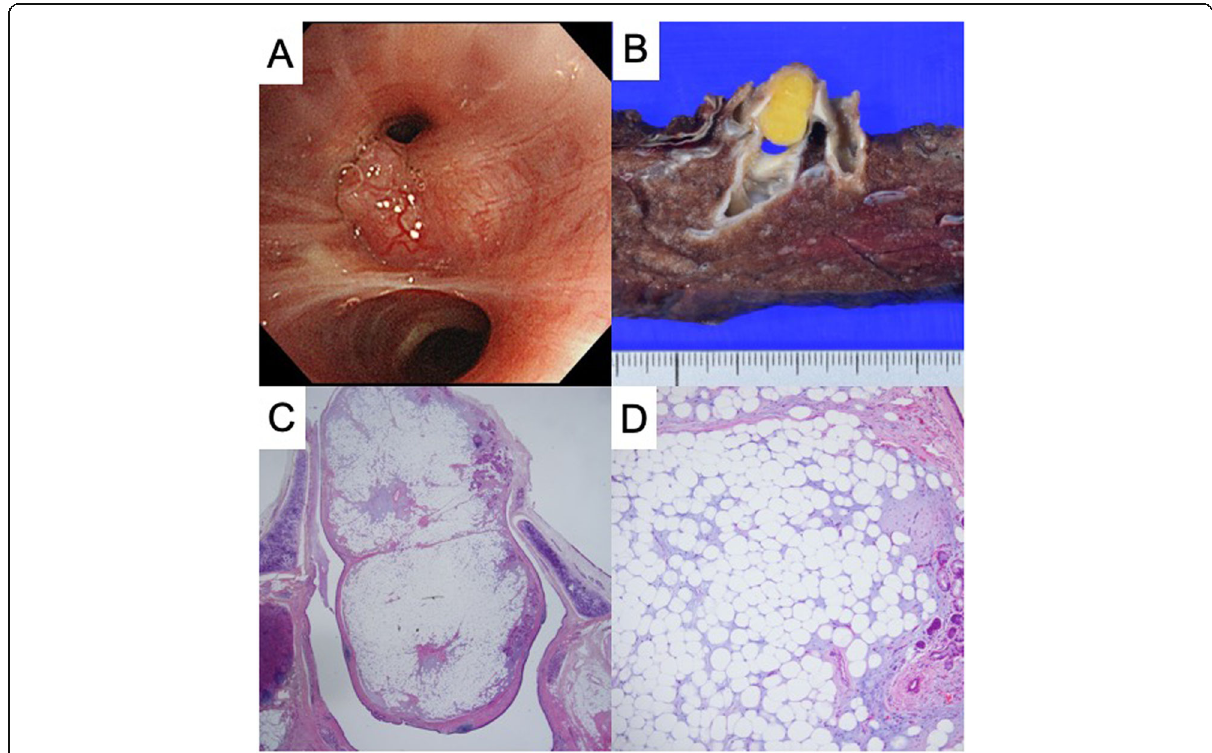
Fig. 2 Pathological findings. a Bronchoscopy findings of a relatively well-defined, smooth tumor that fully occluded the lumen of the lateral segmental bronchus of the right lower lobe (B 9 ). b Macroscopic examination of the right basal segmental specimen showing that the